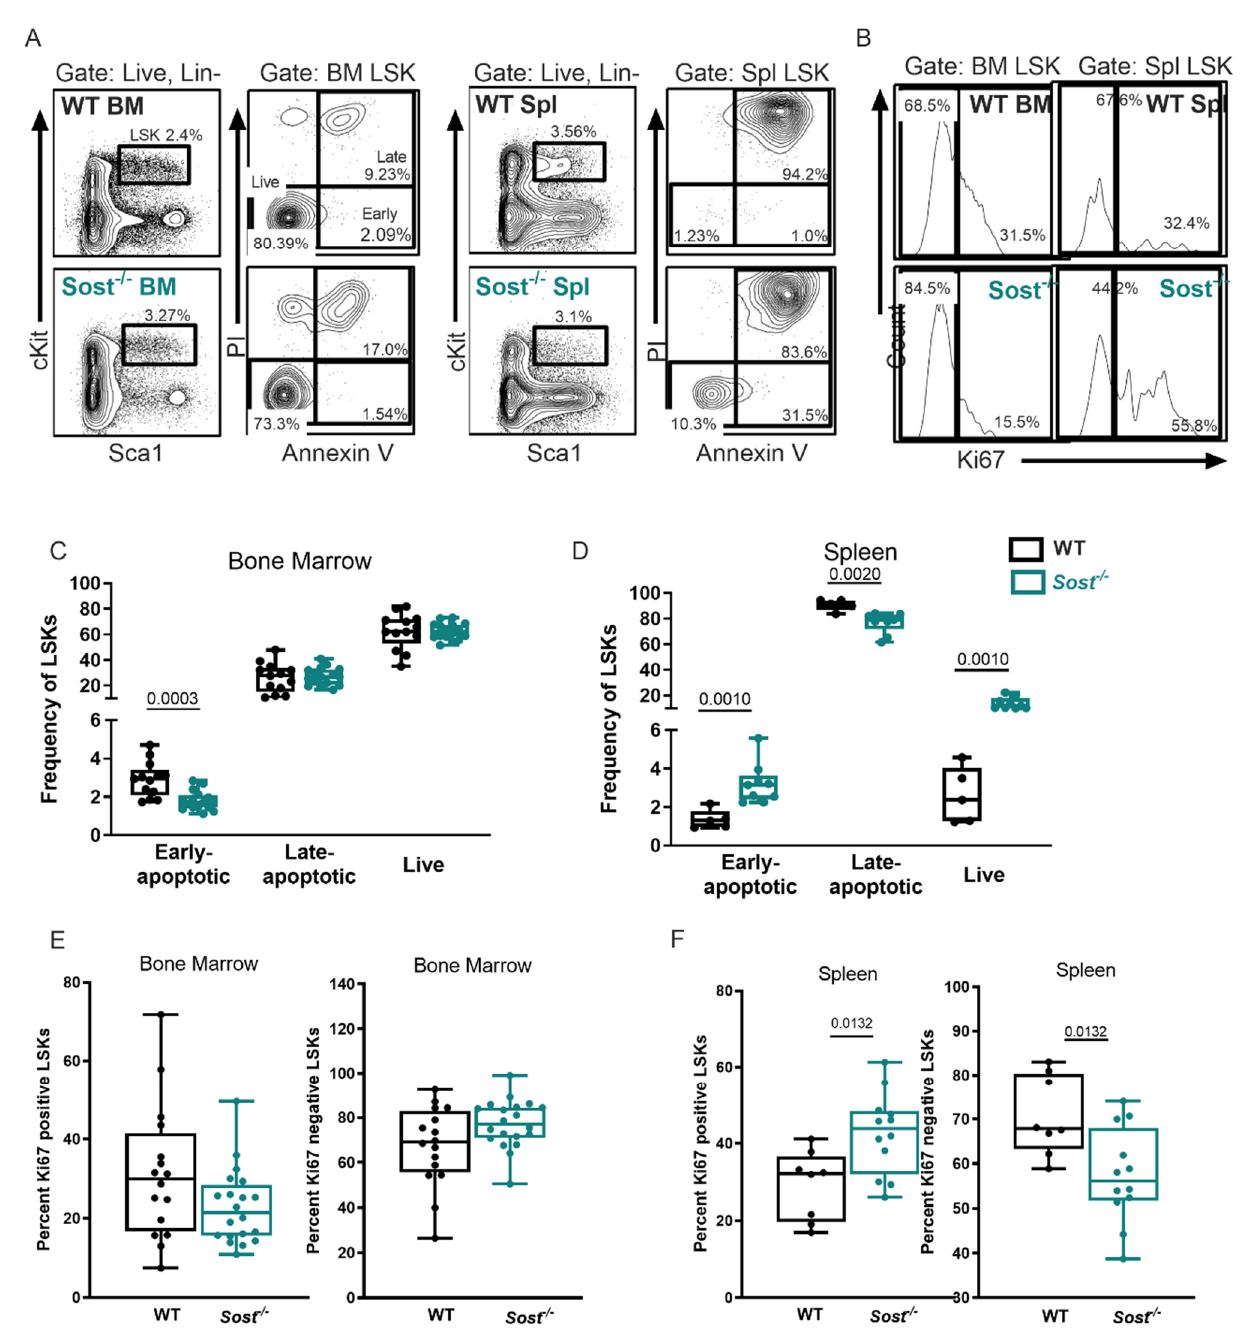
Figure 5. BM and splenic LSKs in Sost − / − mice display opposite patterns of proliferation and early apoptosis. ( A ) Repre- sentative FACS analysis of LSKs stained with annexin V and PI, showing live cells, and cells in early and late apoptosis; ( B ) FACS analysis of LSKs stained with Ki67; ( C ) summary of apoptosis staining results in the LSKs of the BM; ( D ) summary of apoptosis staining results in the LSKs of the spleen; ( E ) frequencies of Ki67 + BM LSKs; ( F ) frequencies of Ki67 + splenic LSKs. Data on apoptosis were compiled from 2 independent experiments, using male mice with ages ranging from 6 to 63 weeks, with age-matched controls in the same experiment. Data on proliferation were compiled from 3 independent experiments, using male and female mice with ages ranging from 23 to 54 weeks. The actual p -values are shown, under- lined.